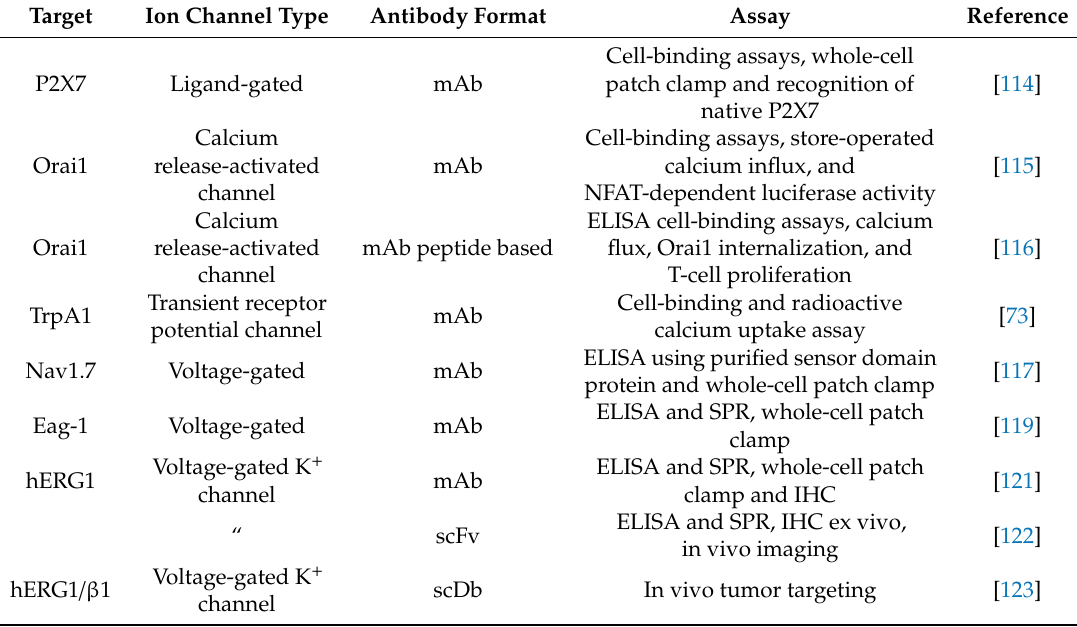
Table 5. Ion channel-targeting antibody-based tools developed or under development. P2X7, ionotropic ATP-gated receptors; Eag-1, ether- à -go-go-1.